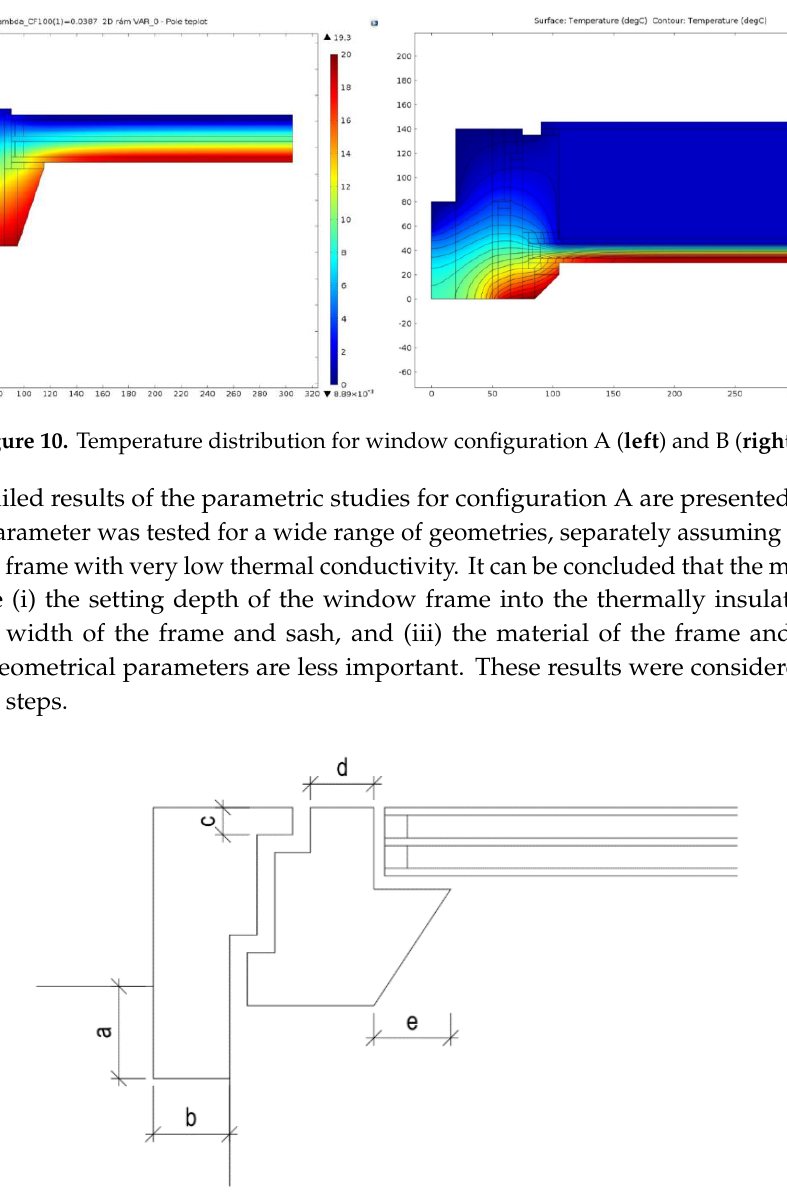
Figure 11. Schematic of a window cross-section showing the most important parameters analyzed in parametric studies.